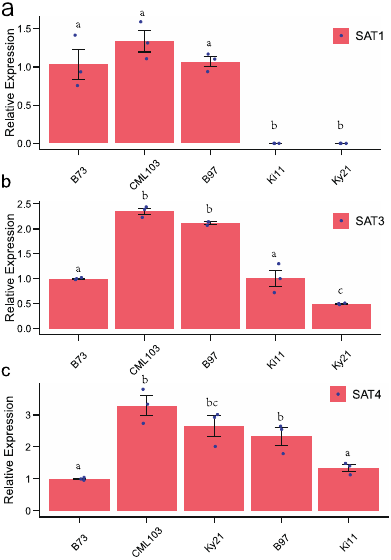
Figure 5. Quantitative real-time PCR for SAT gene expression. ( a ) SAT1 expression. ( b ) SAT3 expression. ( c ) SAT4 expression in B73, B97, CML109, Ki11 and Ky21. An ANOVA test was conducted to assess the statistical difference ( p -value of 0.05). The black bars show the ± standard errors. “a”, “b”, “c” on top of each bar indicate statistics groups.